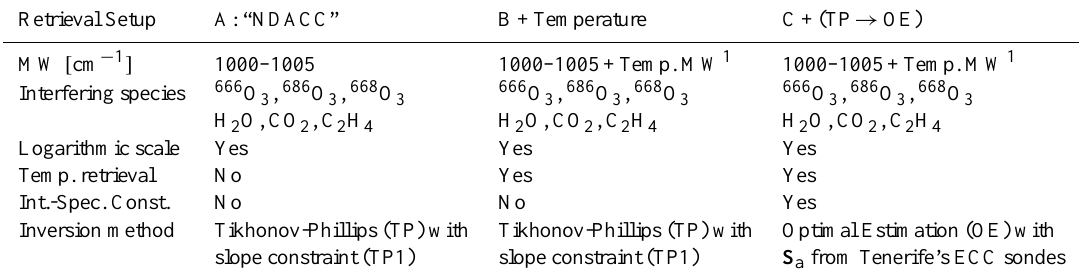
Table 1. Description of FTIR ozone retrieval setups. Note that the level of refinement increases from the setup A to the setup C. 1 Four temperature microwindows (MW) with isolated CO 2 signatures [cm − 1 ]: 962.80–963.80, 964.25–965.25, 967.20–968.20, 968.60–969.60.